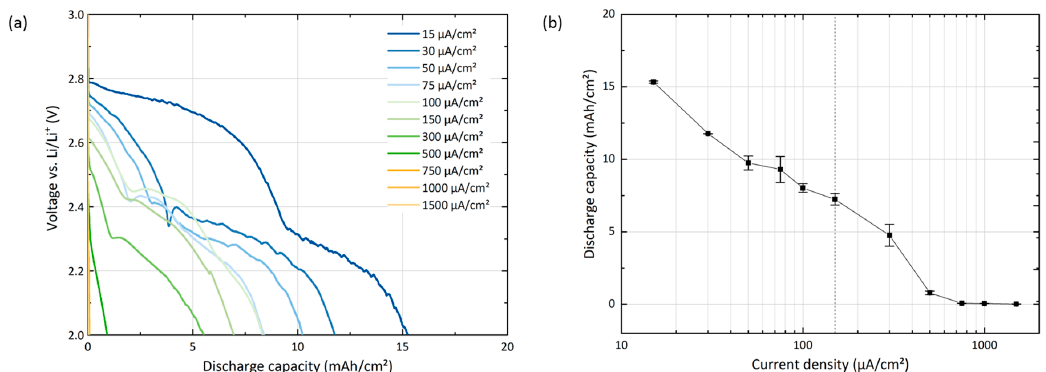
Figure 1. Discharge data for GNS-foam electrodes with current densities between 15 µA/cm 2 and 1.5 mA/cm 2 . ( a ) U ( Q ) profiles. ( b ) Q ( j ) plot with the data of three cells for each current density. The dashed line indicates the standard rate of 150 µA/cm 2 . A logarithmic and a normalized representation of the data, with better visibility of the discharge curves at high current densities, can be found in the supporting information (Figure S1).